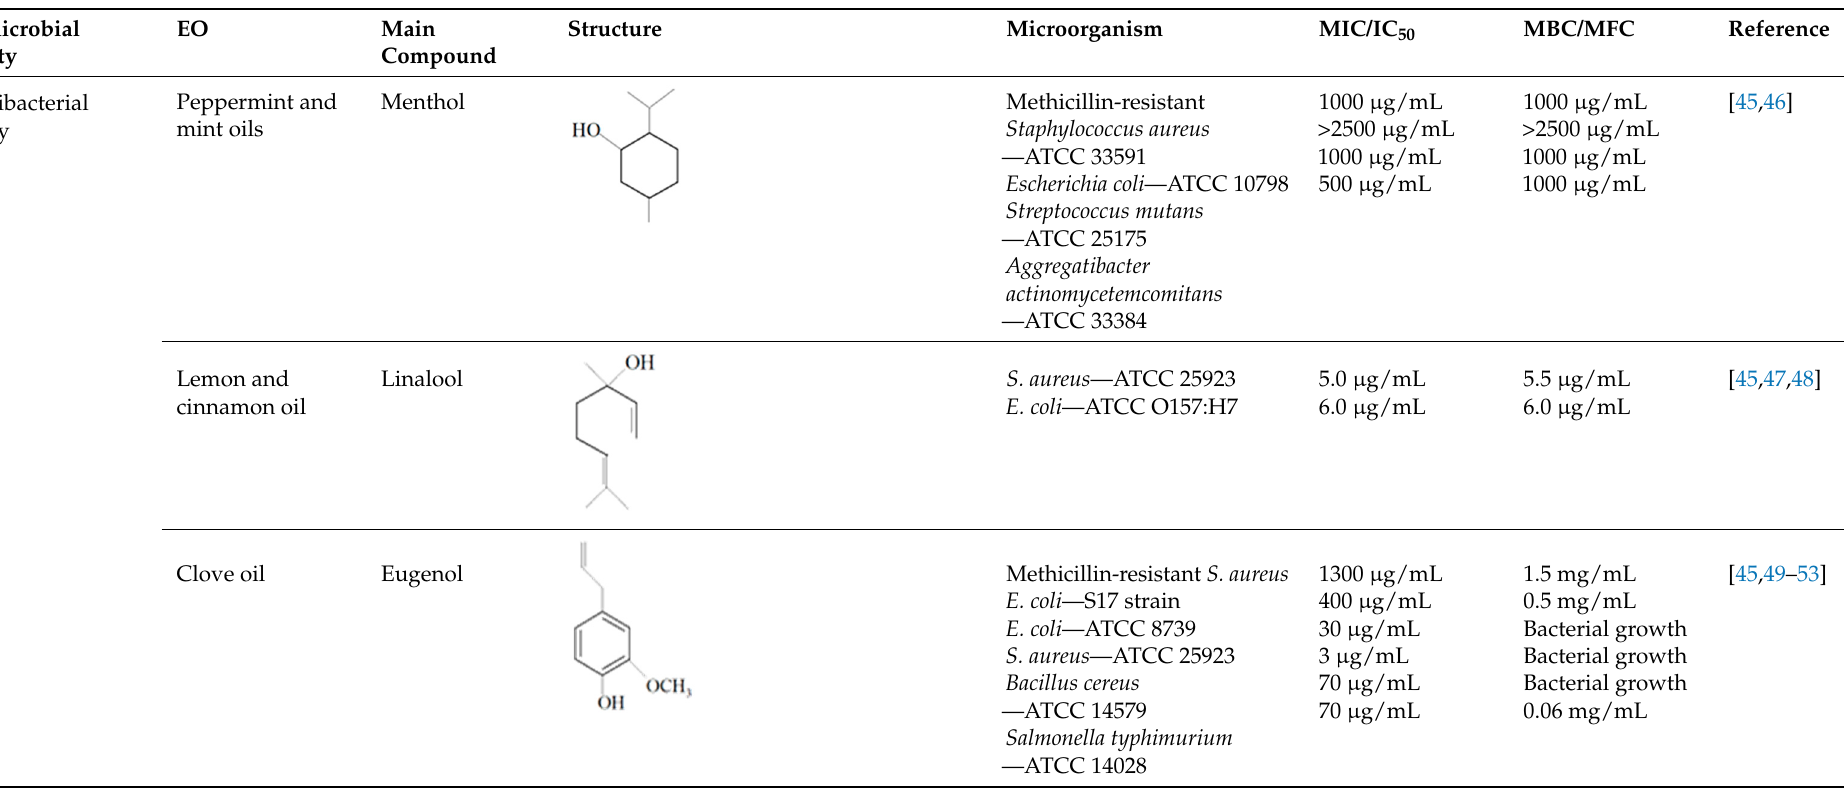
Table 1. Antimicrobial activity of some essential oils (EO) compounds against different microorganisms.